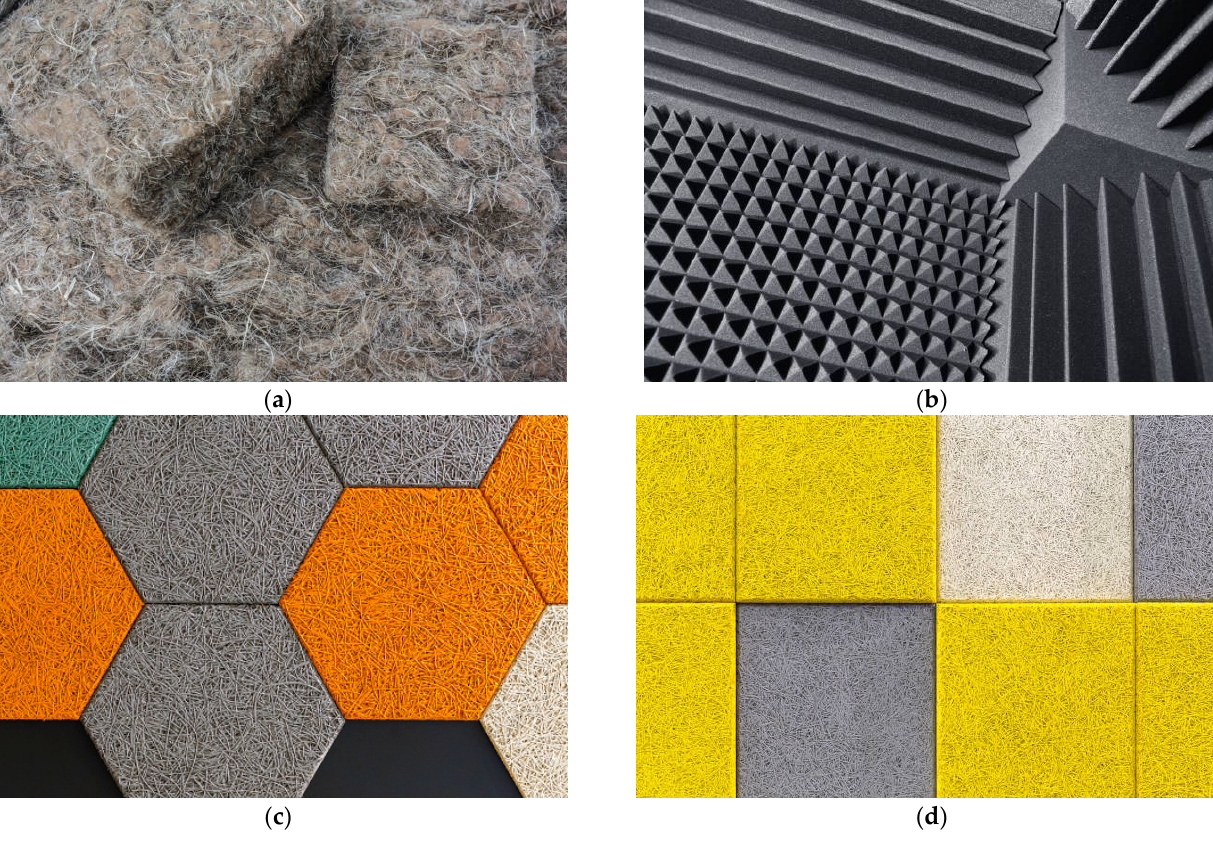
Figure 2. Examples of possible solutions for acoustic insulation: ( a ) hemp isolation material; ( b ) textile acoustic panels; ( c ) wool acoustic panels; ( d ) synthetic textile waste panels.